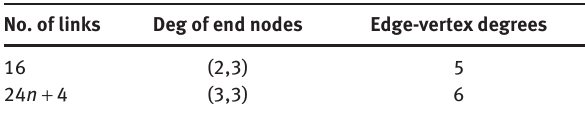
Table 1: Link partitioning of (